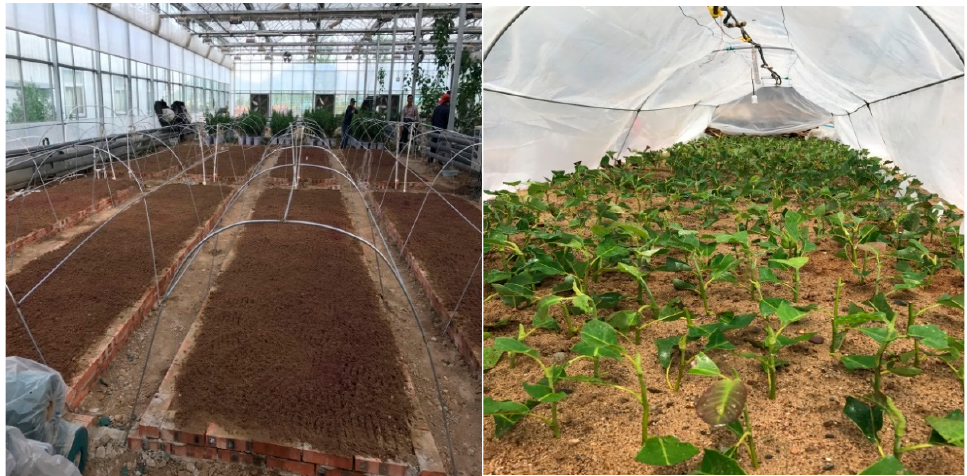
Figure 2. Cutting seedbeds and